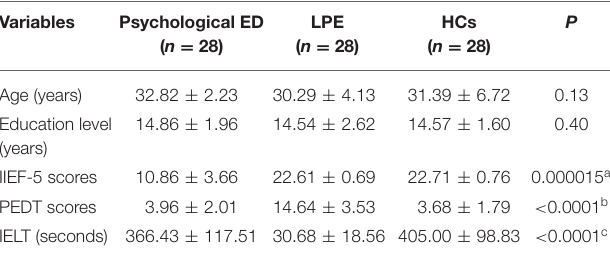
TABLE 1 | Demographic and clinical